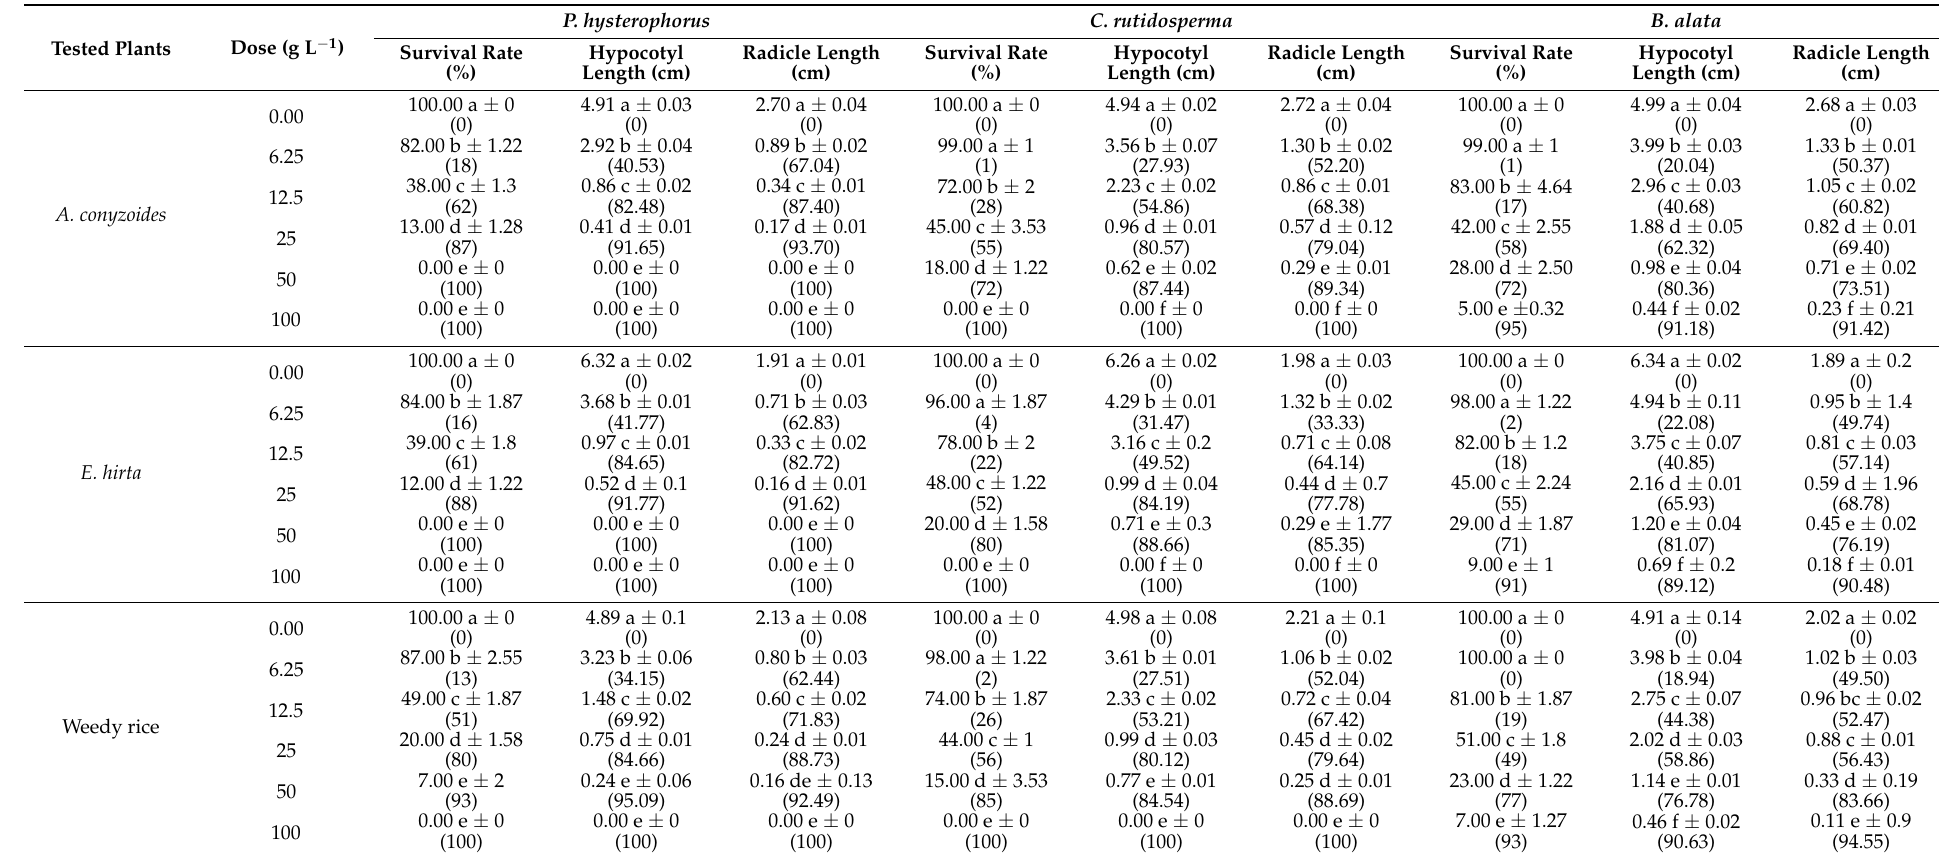
Table 1. Effects of P. hysterophorus , C. rutidosperma , and B. alata methanol extracts on survival rate (%), hypocotyl, and radicle length (cm) of the tested weed